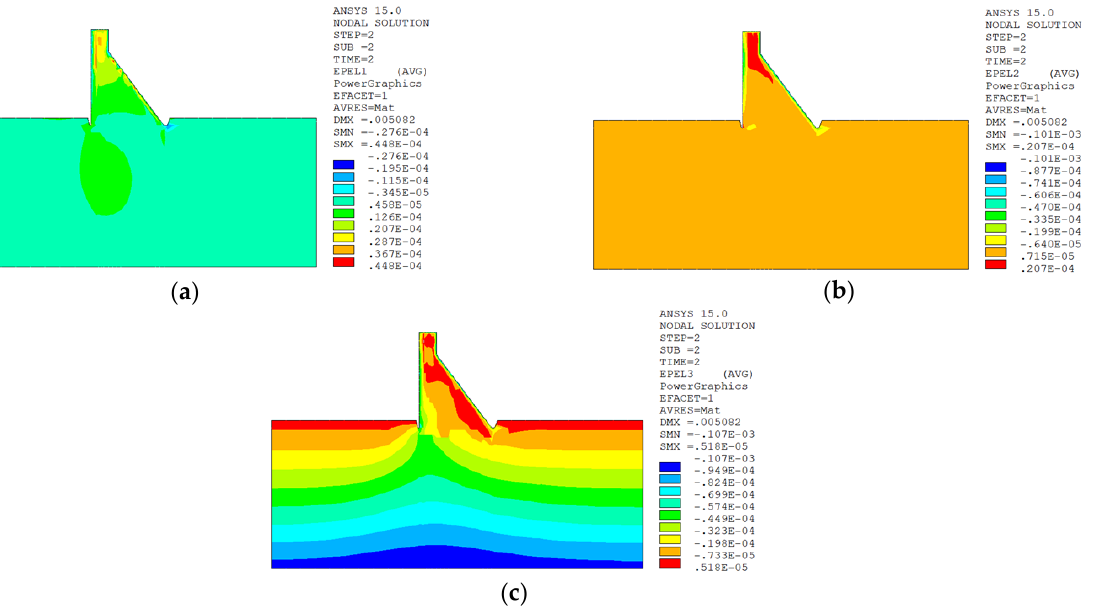
Figure 26. The cloud charts of the three principal strains on the section z = 21 m are calculated by the macro model under the temperature rise condition, ( a ) The cloud chart of the first principal strain, ( b ) The cloud chart of the second principal strain, ( c ) The cloud chart of the third principal strain.